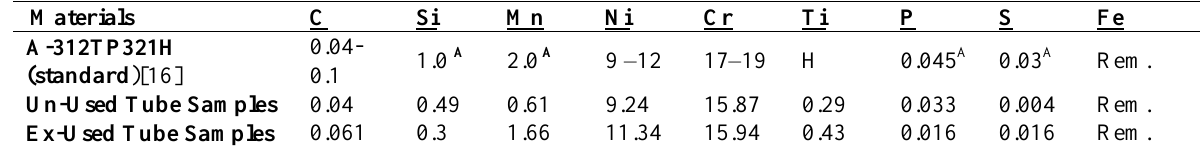
Composition of material tubes samples.